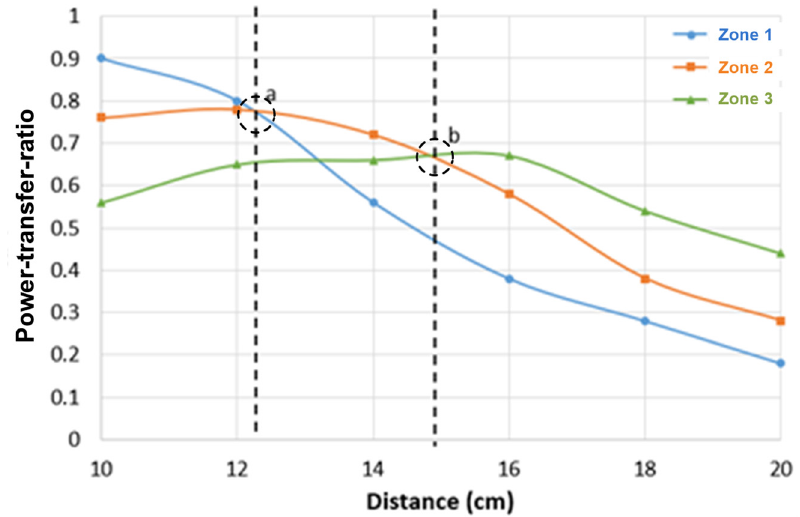
Figure 12. The power-transfer ratio from the transmitter coil to the receiver coil versus transmission distance in three operating zones.